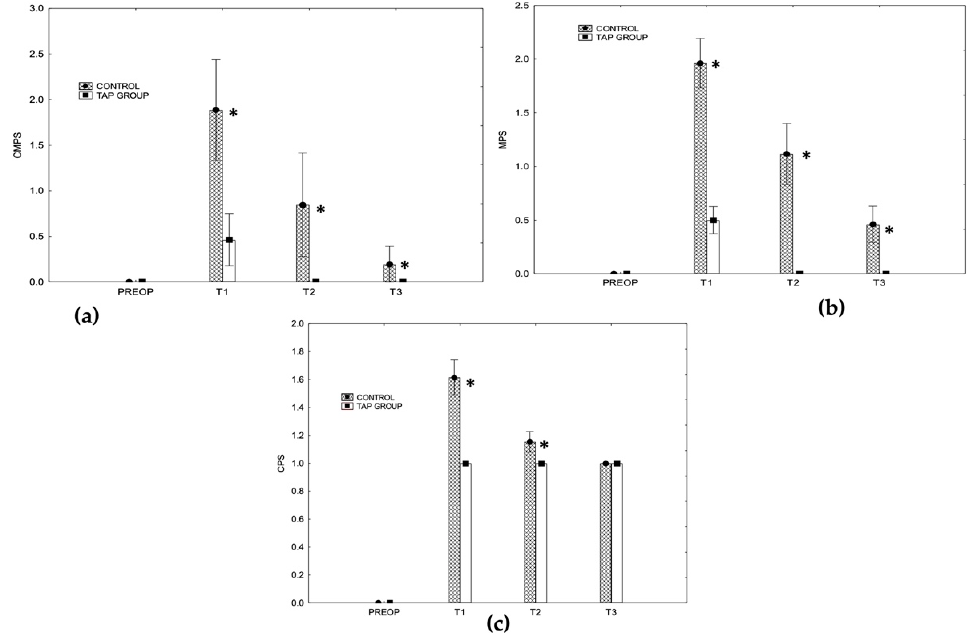
Figure 2. The bars indicate the pain scores’ mean and standard deviation values for both groups at the different time points according to the ( a ) Glasgow Composite Pain Measurement Scale (CMPS), ( b ) the Melbourne Pain Scale (MPS), and ( c ) the Colorado Pain Scale (CPS). The asterisks (*) indicate significant differences between both